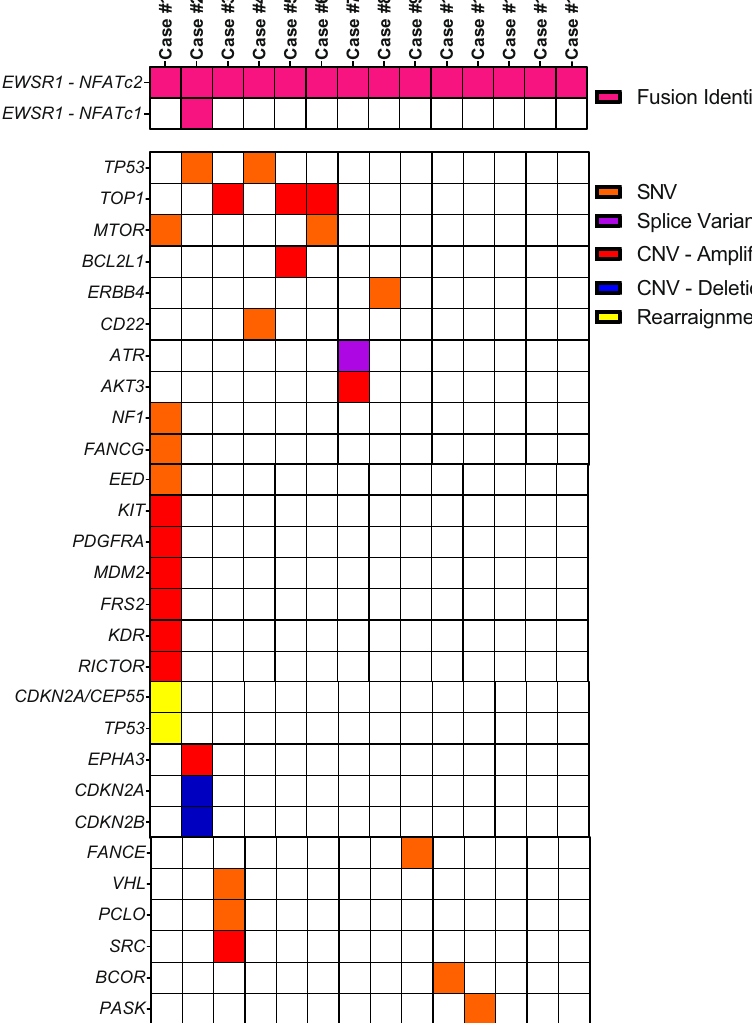
Fig. 1 Genomic landscape of EWSR1-NFATc2 fusion positive sarcomas. Heatmap of the presence or absence of known pathogenic genomic variants in 14 subjects with EWSR1-NFATc2 fusion positive sarcoma identi fi ed in the FMI research database. The EWSR1-NFATc2 fusion was identi fi ed as the only pathogenic genomic variant in three subjects (27.3%), while one subject exhibited both an EWSR1-NFATc2 and EWSR1- NFATc1 fusion simultaneously. Secondary pathogenic genomic variants were identi fi ed in TOP1 , TP53 , BCOR , AKT3 , ATR , BCL2L1 , CD22 , CDKN2A, CDKN2B , EPHA3 , ERBB4 , FANCE , and mTOR . Only three genes, mTOR, TOP1 , and TP53 , exhibited pathogenic variants in more than one subject. SNV single nucleotide variant, CNV copy number